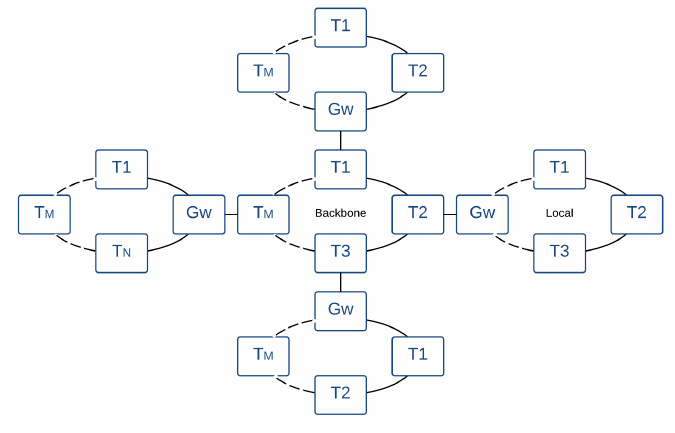
Figure 5. Multiple-ring network